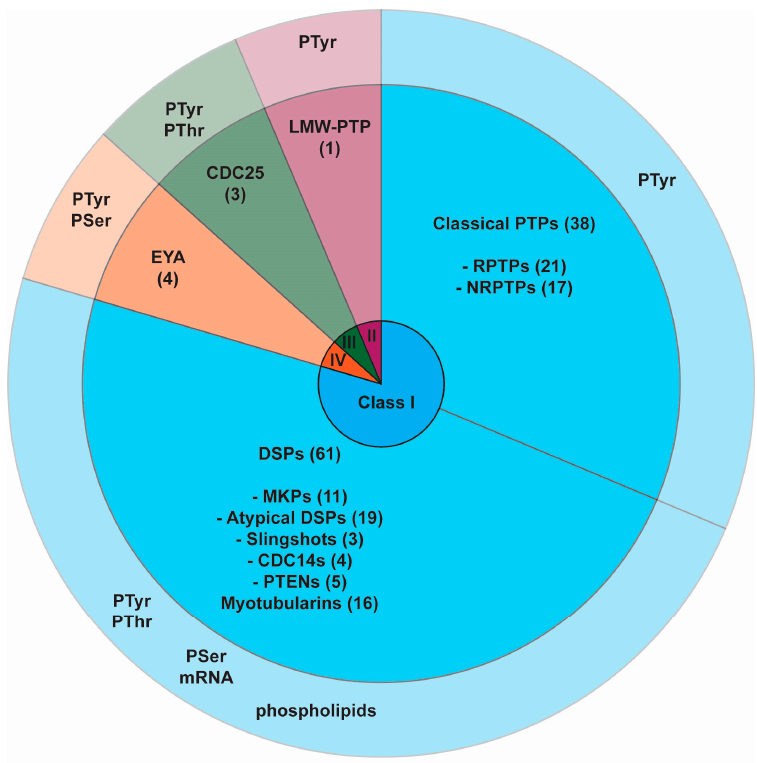
Figure 1. Protein tyrosine phosphatase (PTP) superfamily. Class 1-IV PTPs detailed in inner rings, with their substrate specificities stated in the outer ring.